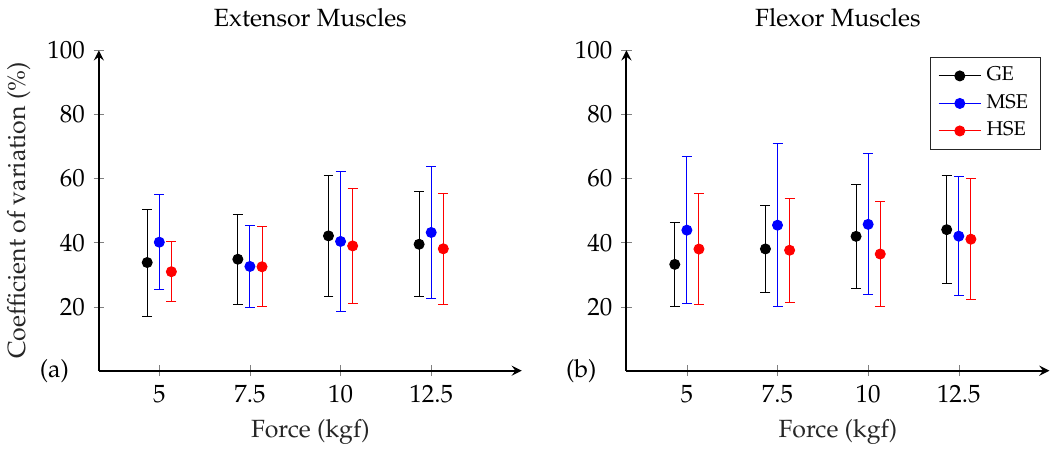
Figure 5. Mean and standard deviation of coefficient of variation (in %) of SEMG data of all participants collected on the ( a ) extensor and ( b ) flexor muscles of the forearm over five trials at different force level for each electrode type.